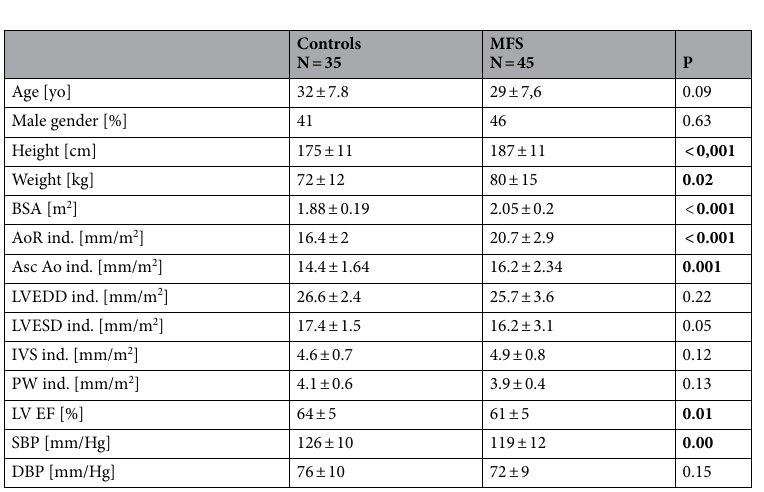
Table 2. Left ventricular and aortic remodeling in humans. BSA body surface area, AoR aortic root diameter, Asc Ao ascending aorta diameter, LVEDD left ventricular end-diastolic diameter, LVESD left ventricular end-systolic diameter, LVEF left ventricular ejection fraction, IVS interventricular septum thickness, PW left ventricular posterior wall thickness, SBP systolic blood pressure, DBP diastolic blood pressure, ind. indexed by BSA. Continuous variables data is presented as mean ± SD. Independent two-sample t-test for normally distributed continuous variables and the Mann–Whitney U test for non-parametric distribution. Categorical variable (male gender) is presented as percentage (%) and compared using χ 2 test. P<0.05, in bold, denote statistical